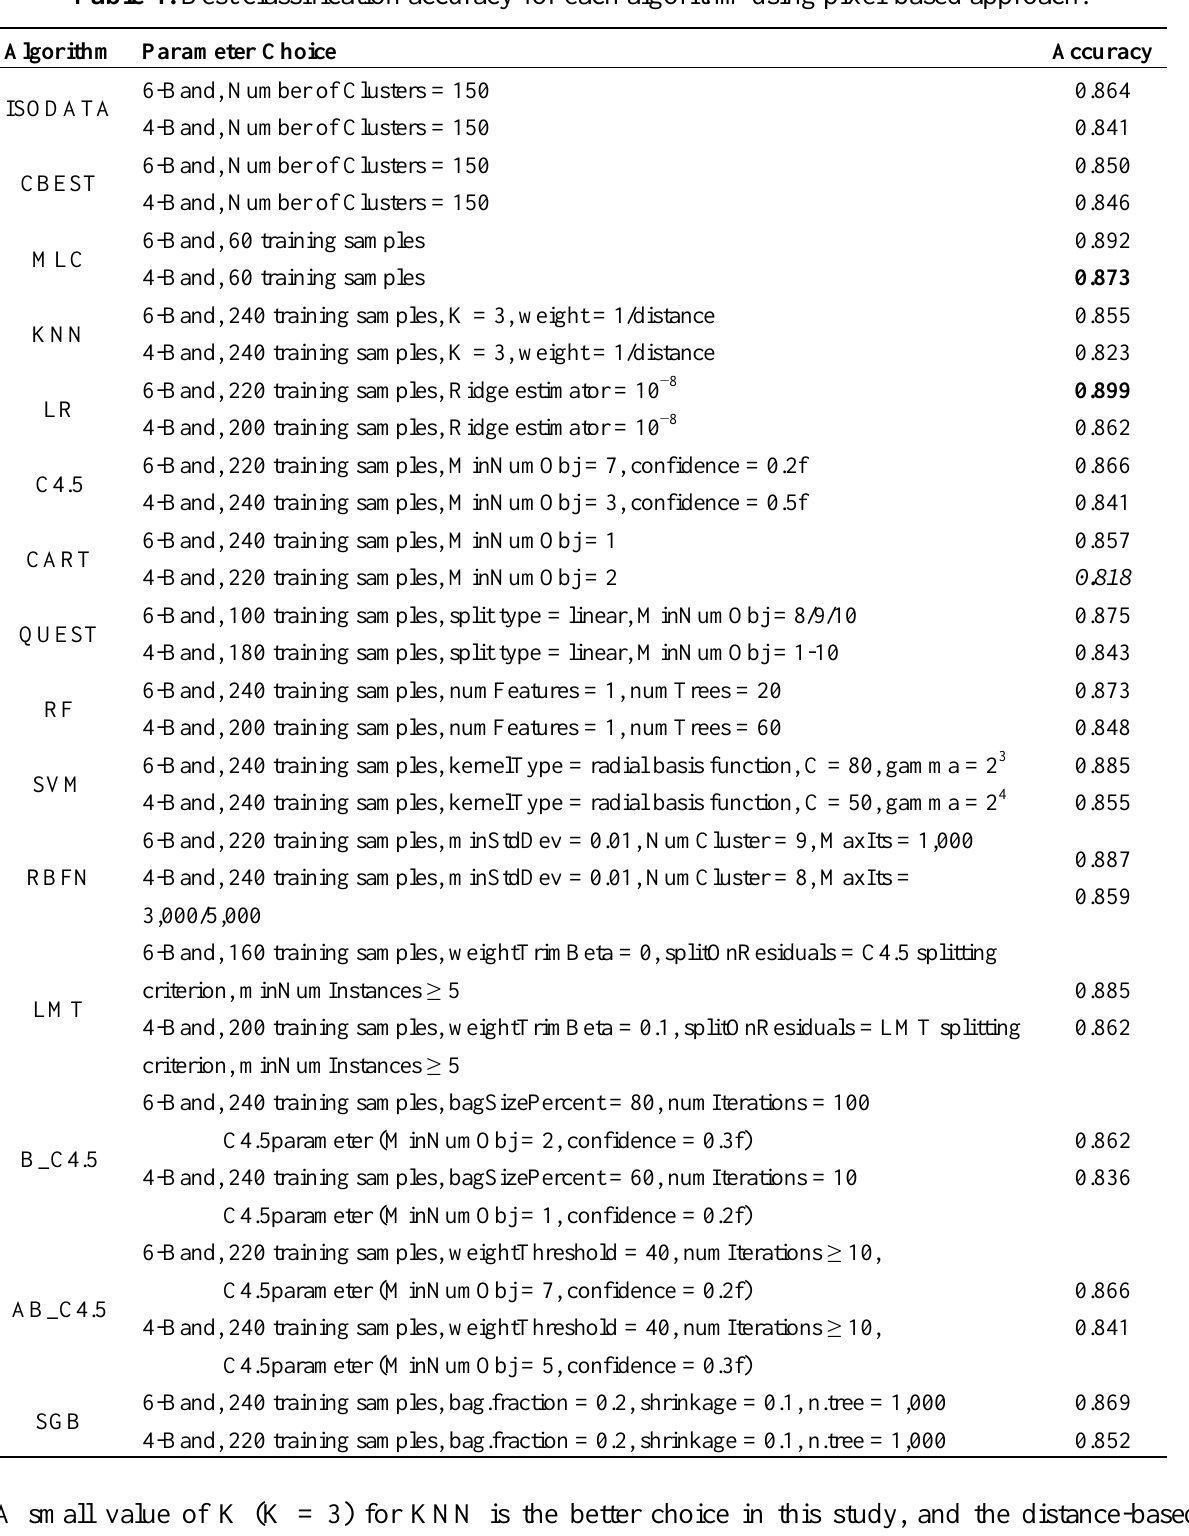
Table 4. Best classification accuracy for each algorithm using pixel-based